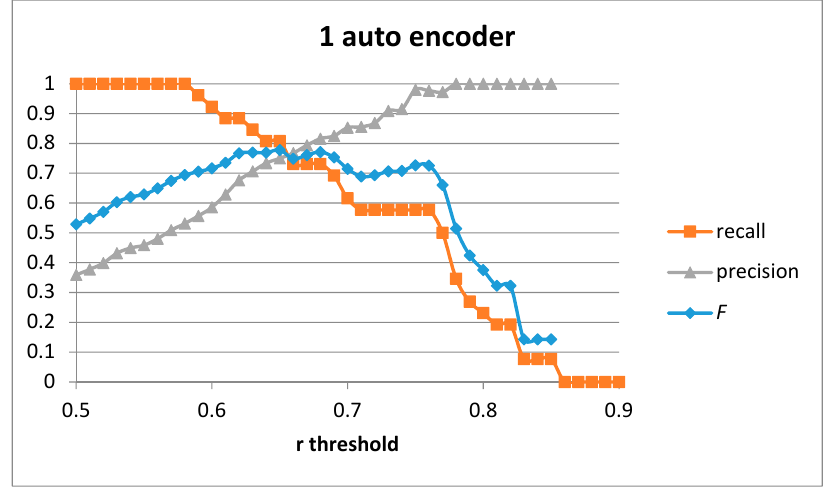
Figure 11. Precision, recall, and F score for 1 auto-encoder and 100 hidden units. Table 8. Classification results for one layer of auto-encoders and recall 0.615.